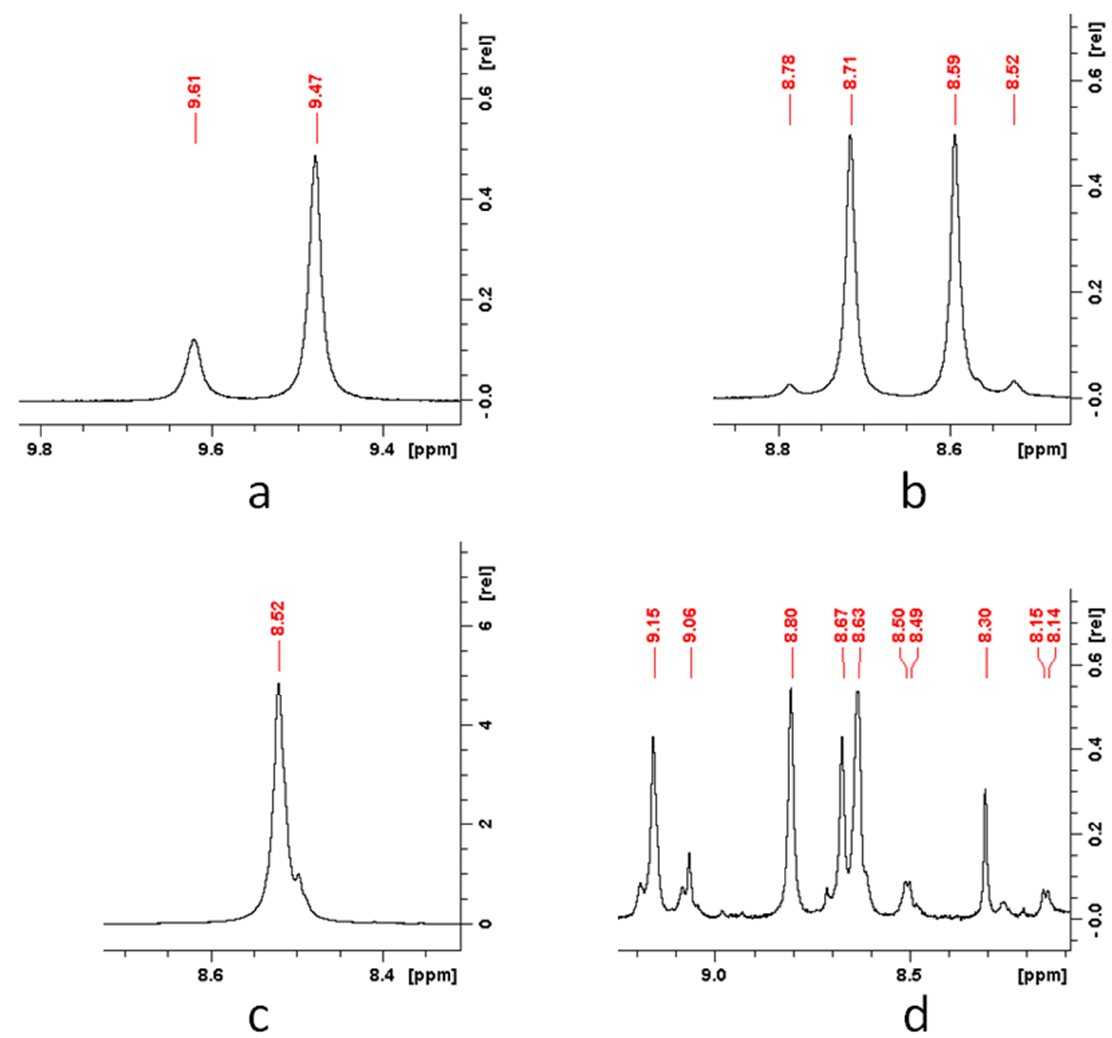
Figure 4. 1 H NMR spectra of model compounds: 4,4’ ‐ MDI ‐ 530PCL ( a ), 4,4’ ‐ MDI ‐ BAPS ( b ), 4,4’ ‐ MDI ‐ 4,4’ ‐ MDI ( c ), 2,4 ‐ TDI ‐ BAPS ( d ).